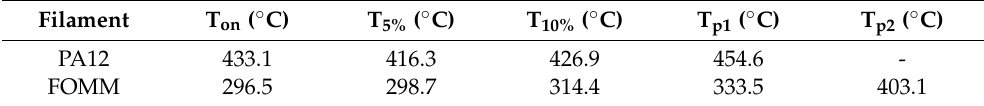
Table 1. Reference temperatures obtained by